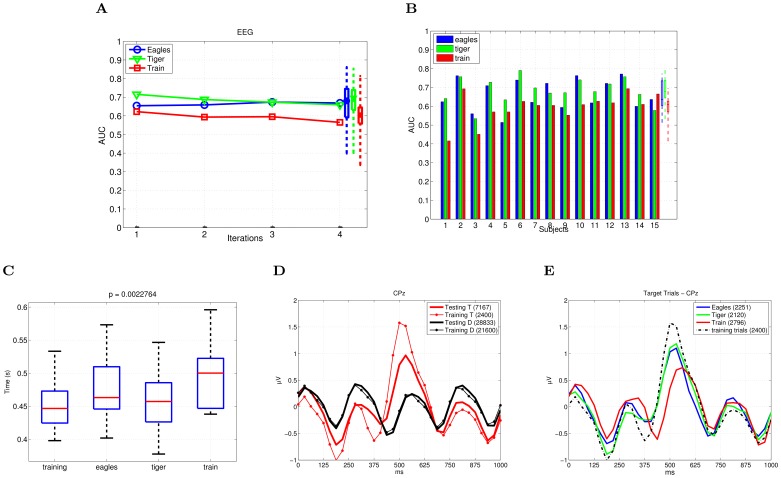
EEG-based Image Labeling.(A) Average EEG-based labeling performance (AUC) across subjects. (B) Single trial EEG classification performance (AUC) on the EEG data averaged across the iterations, given for each subject individually. The rightmost boxplots show the median (the central mark of the box), the 25th and 75th percentiles (the edges of the box) and the most extreme performance (dashed lines) over all subjects per search task. (C) Median response time (in seconds) across subjects for the different search tasks. (D–E) Grand Average of the potentials evoked by the target and distractor images at CPz: Training vs. testing sequences and Individual testing tasks as compared to the training task.